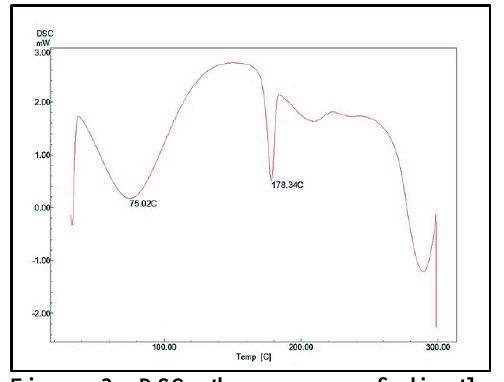
Figure 3. DSC thermogram of directly compressed tablet (DCT).